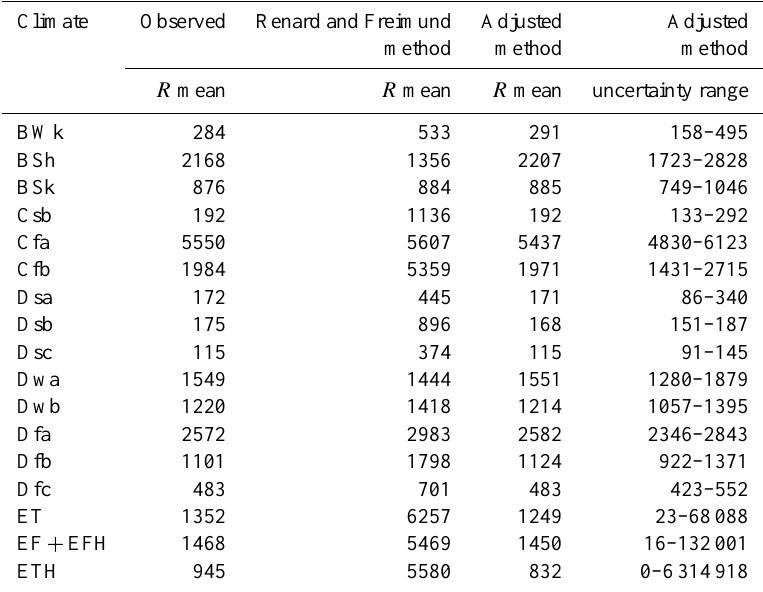
Table 6. Mean high resolution R values (MJmmha − 1 h − 1 year − 1 ) from the USA and Switzerland and mean modelled R values with uncertainty range for each addressed climate